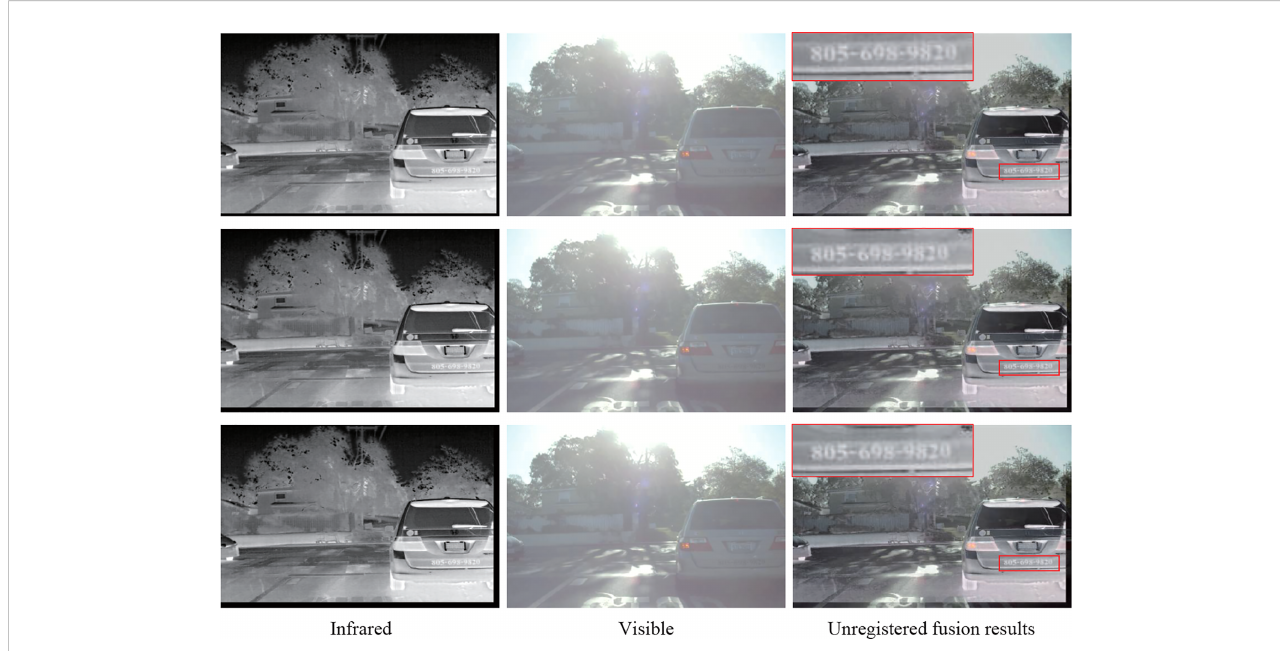
FIGURE 12 The results of fusing unregistered images with the proposed method on the Roadscene dataset. The infrared images are randomly translated, which causes the black edge in the images. The infrared images from top to bottom are translated with [-5,5],[-8,8],[-10,10]